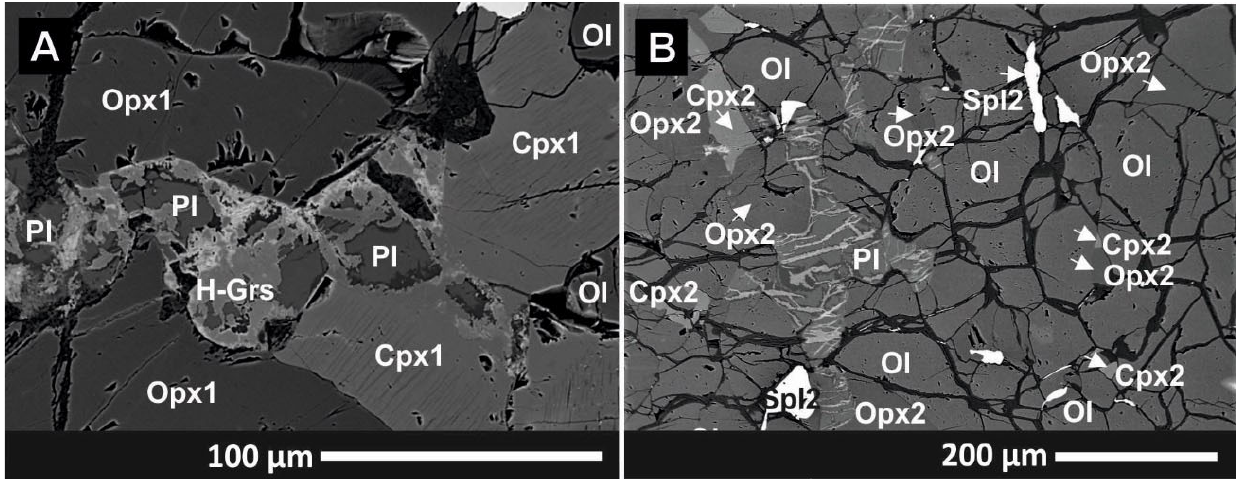
Figure 9. Plagioclase peridotite (s. P8A, lherzolite). ( A,B ) Relics of An ‐ rich Pl in Ab ‐ Czo ‐ H ‐ Grs aggregate.